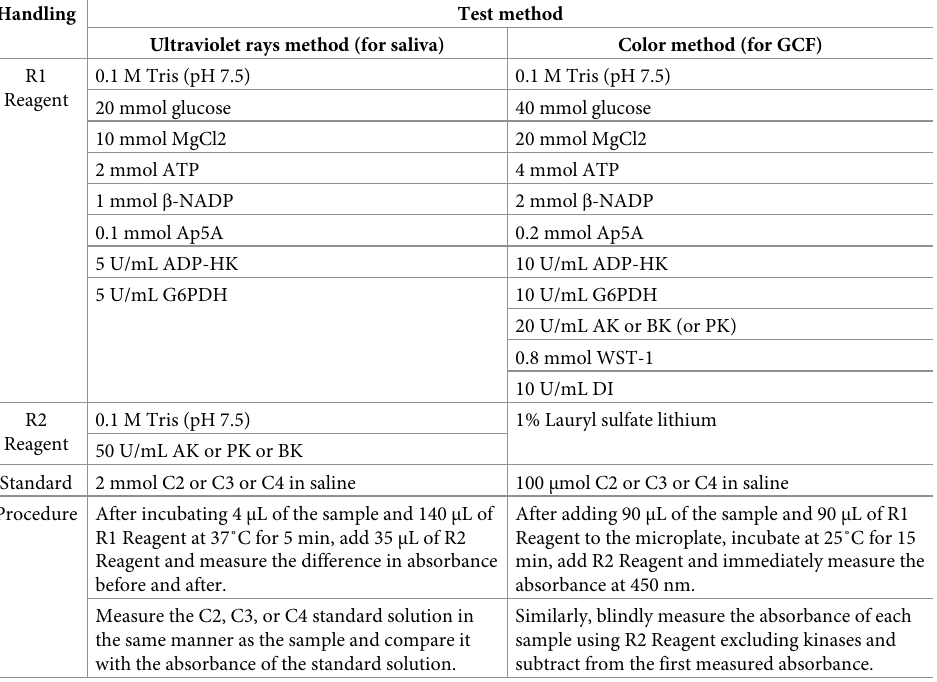
Table 2. Reagent composition and procedures for ultraviolet rays and color methods.